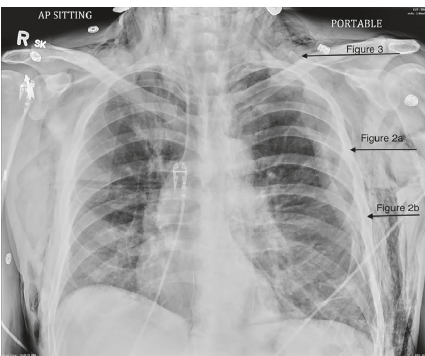
Figure 1: Anteroposterior chest radiograph demonstrating sub- cutaneous emphysema. Anatomic locations of Figures 2(a), 2(b), and 3 are